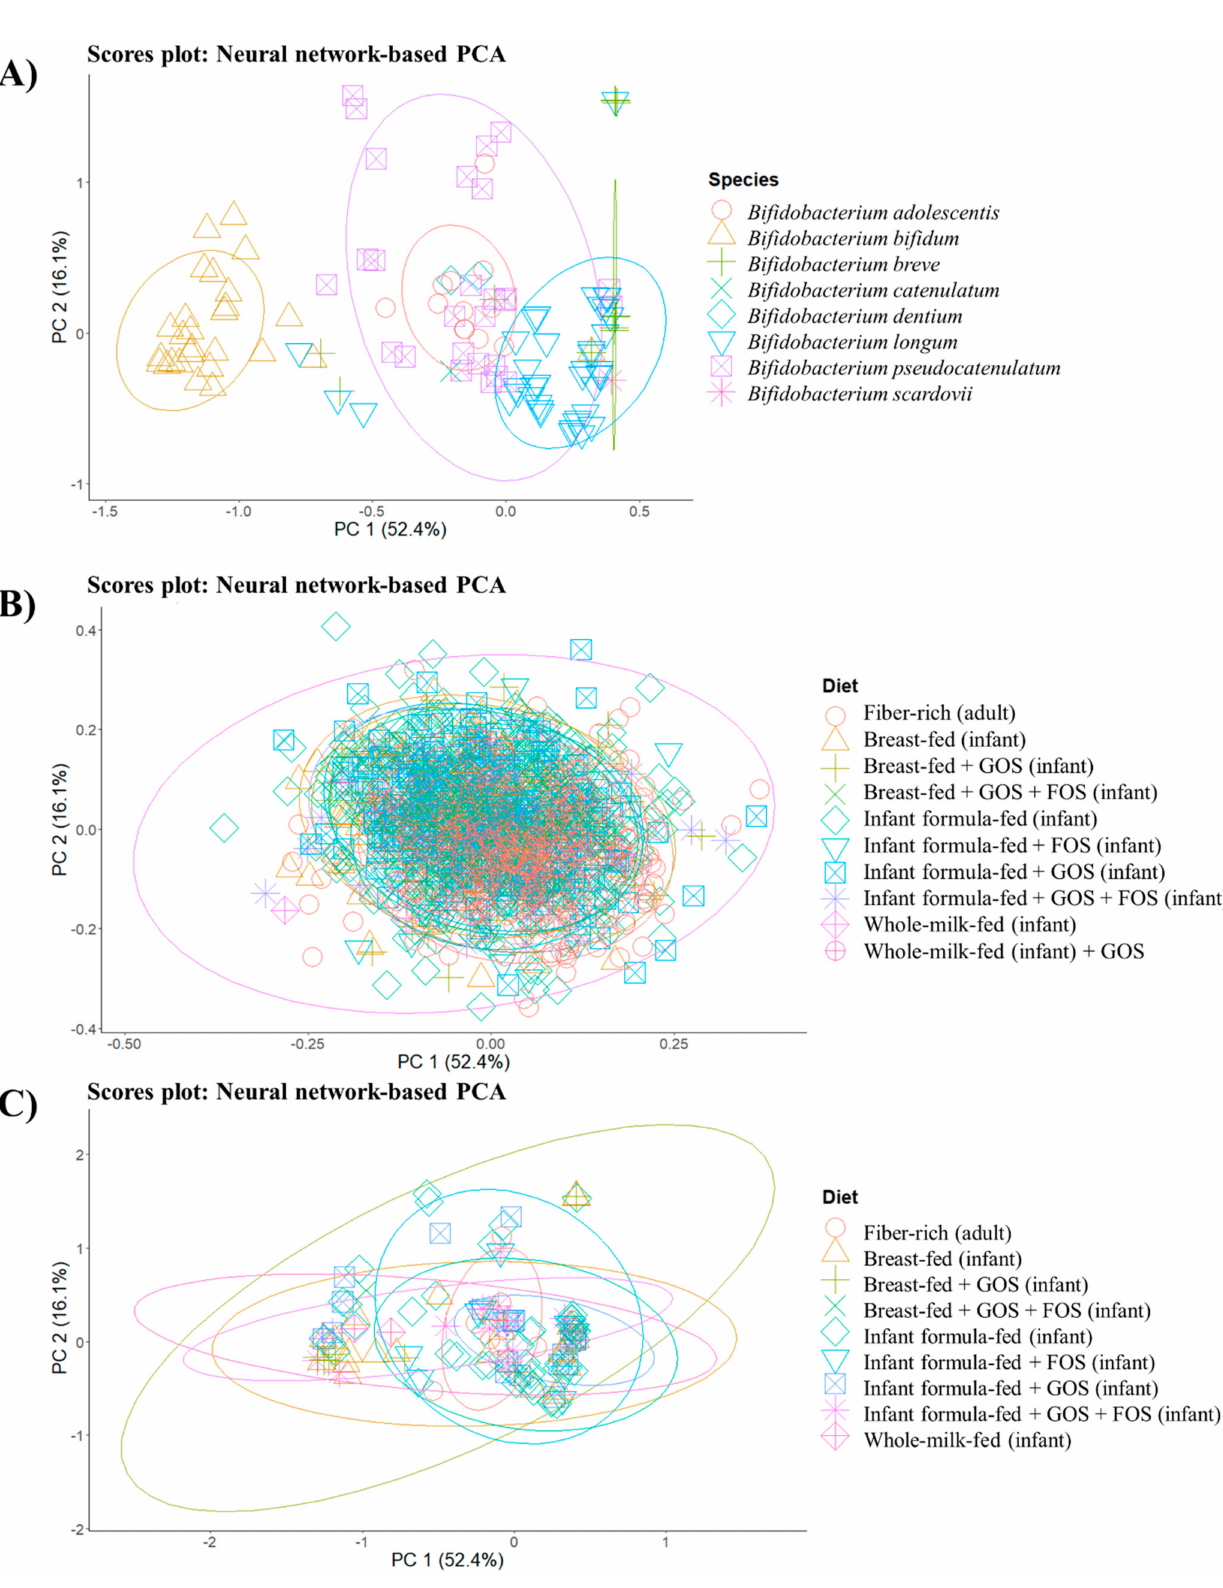
Figure 2. Artificial neural network-based principal component analysis (PCA) of glycosidase activities encoded in metagenome-assembled genomes (MAGs). MAG distribution is illustrated according to two different criteria: char- acteristic profiles of MAG-recovered Bifidobacterium species ( A ), differences in MAGs from all identified species (including not only bifidobacteria) ( B ) and only bifidobacteria species ( C ) depending on the diet. GOS: galacto-oligosaccharides, FOS: